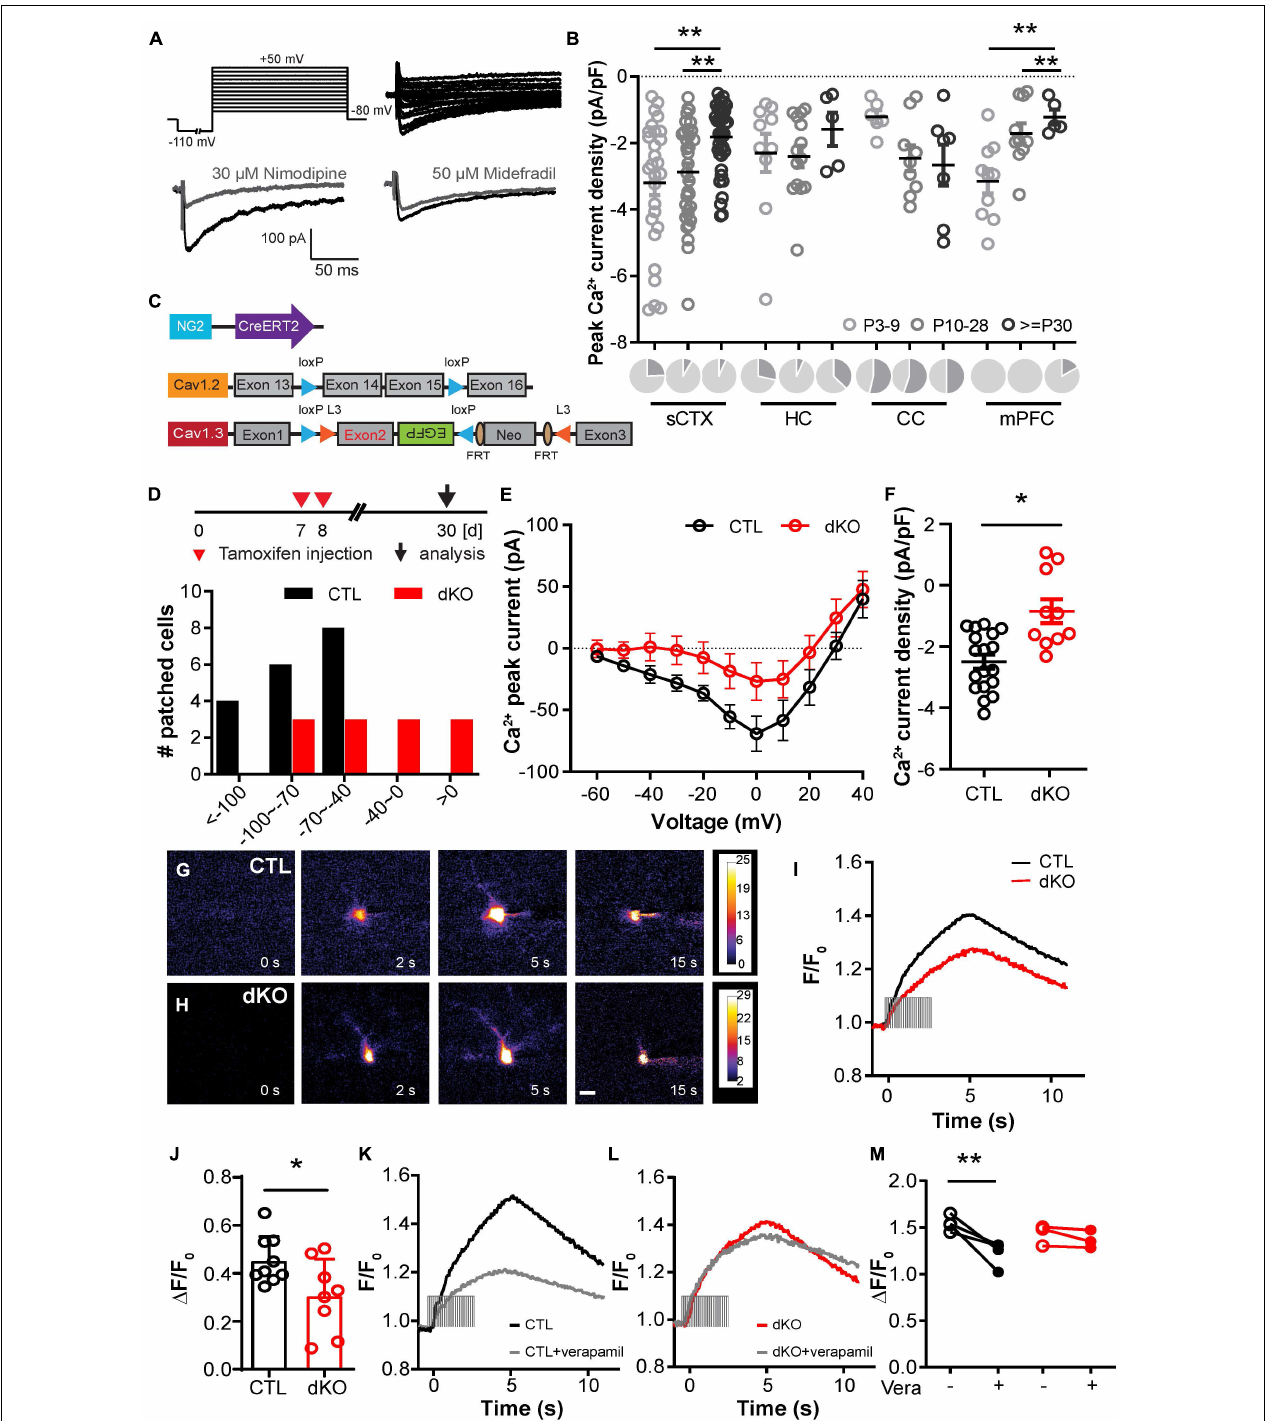
FIGURE 1 | Conditional deletion of L-type voltage-gated Ca 2 + channel subtypes Cav1.2 and Cav1.3 in NG2 glia. (A) Ca 2 + current recordings. Peak inward currents of NG2 glia in the somatosensory cortex were strongly blocked by L-type Ca 2 + channel blocker nimodipine and only weakly blocked by T-type blocker mibefradil. (B) L-type Ca 2 + peak current densities in different brain regions (sCTX, somatosensory cortex; HC, hippocampus; CC, corpus callosum; mPFC, medial prefrontal cortex) during CNS maturation. Within the first month postnatally the expression levels of VGCC decreased by about 30% in cortical areas, but appeared largely unchanged in HC and CC. Each pie chart represents the proportion of NG2 glia with Cav expression (in light gray) and non-Cav expression (in dark gray). (C) Genetically modified mouse lines for NG2 glia-specific Cav1.2 und Cav1.3-specific gene deletion. (D) The upper panel depicts the tamoxifen injection protocol.